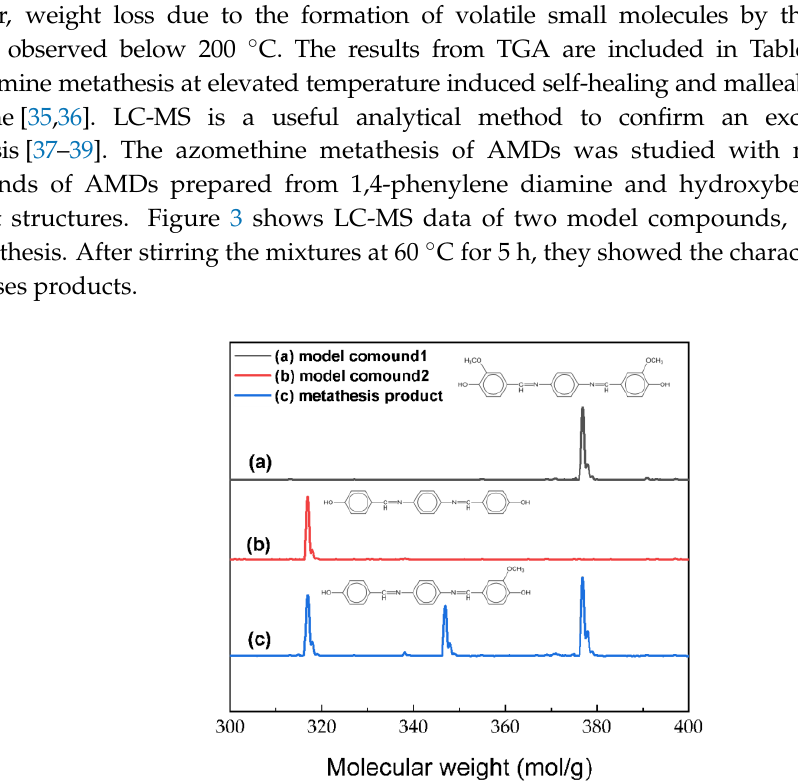
Figure 3. LC-MS results for the metathesis of azomethine diols of different structures: ( a ) Model Compound 1; ( b ) Model Compound 2; and ( c ) metathesis products of model compounds.